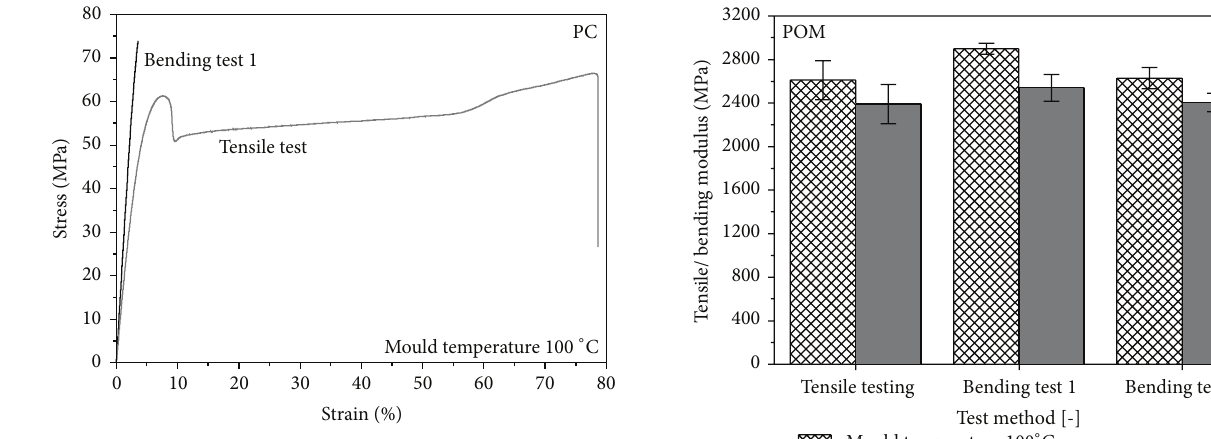
Figure 8: Representative stress/strain curves of bending and tensile test of PC specimens.